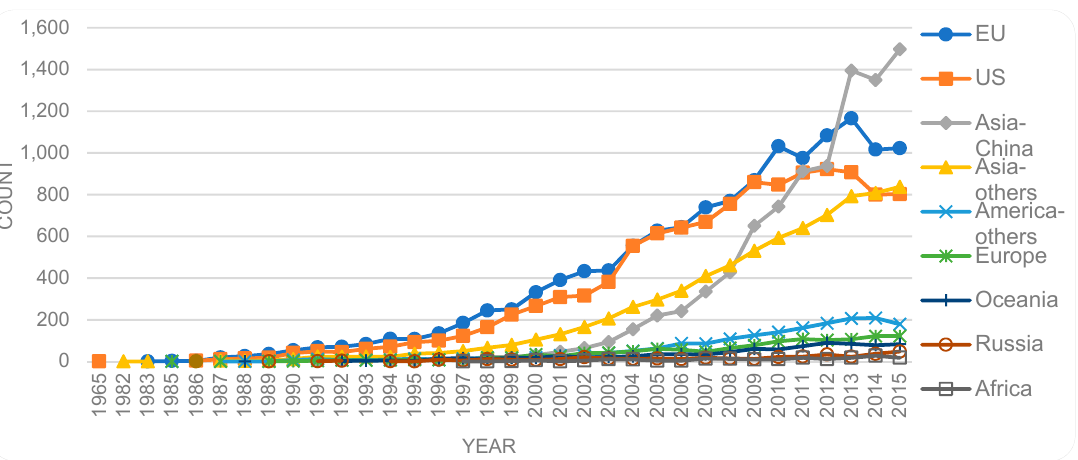
Figure 10. Regional publication trends. Counts of countries of the first authors, grouped in representative regions by year.